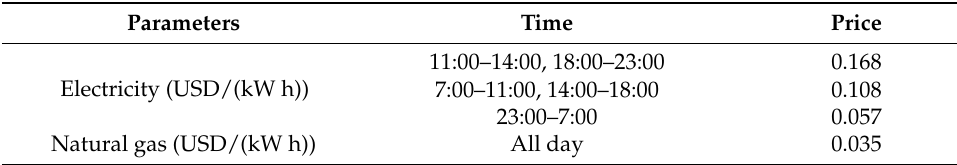
Table 3. Parameters of the energy prices.